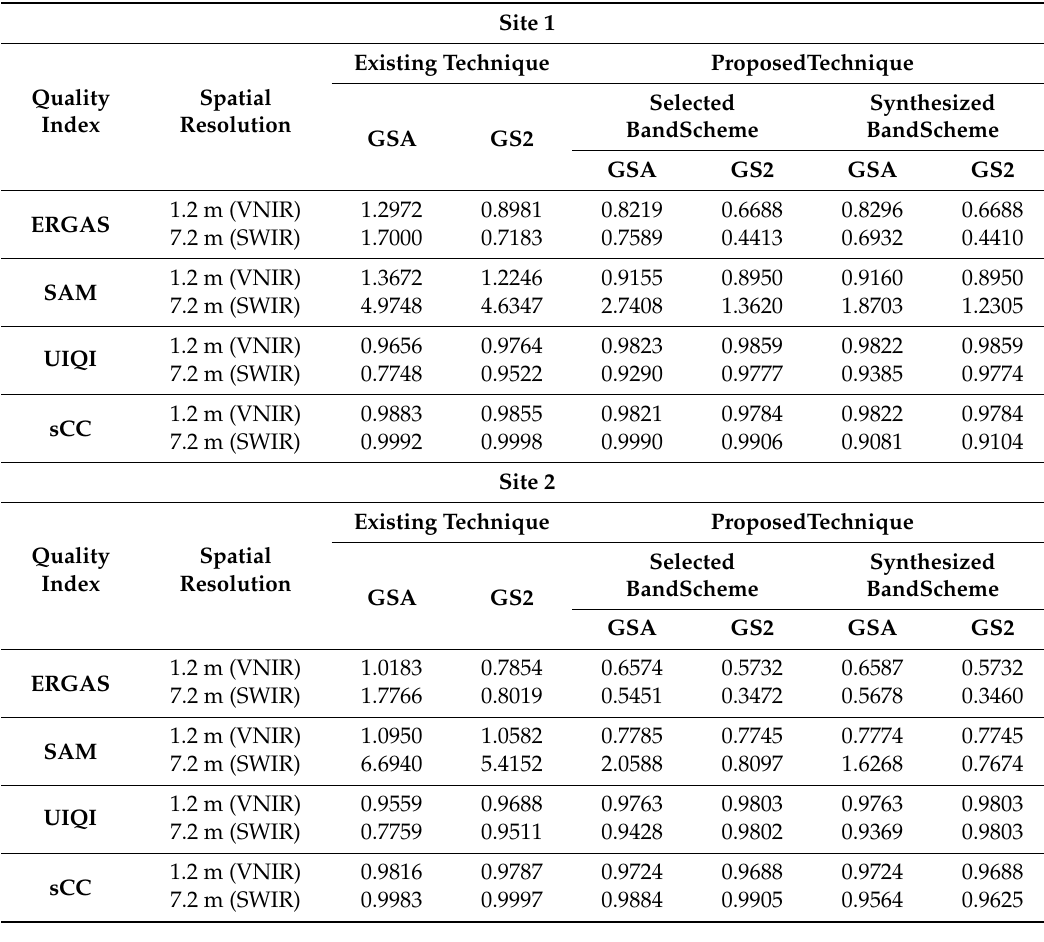
Table 2. Quantitative evaluation results of sharpened Worldview-3 satellite